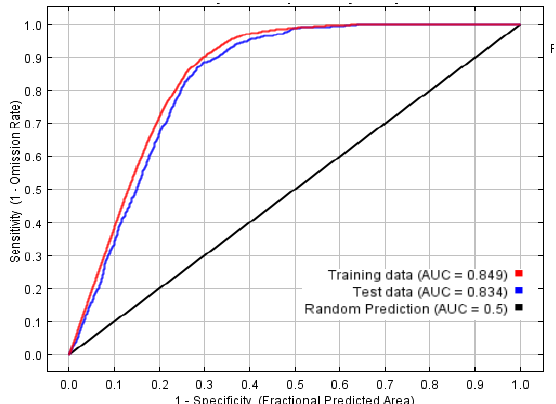
Figure 5. Training and test AUC plot to measure performance of model against second set of data